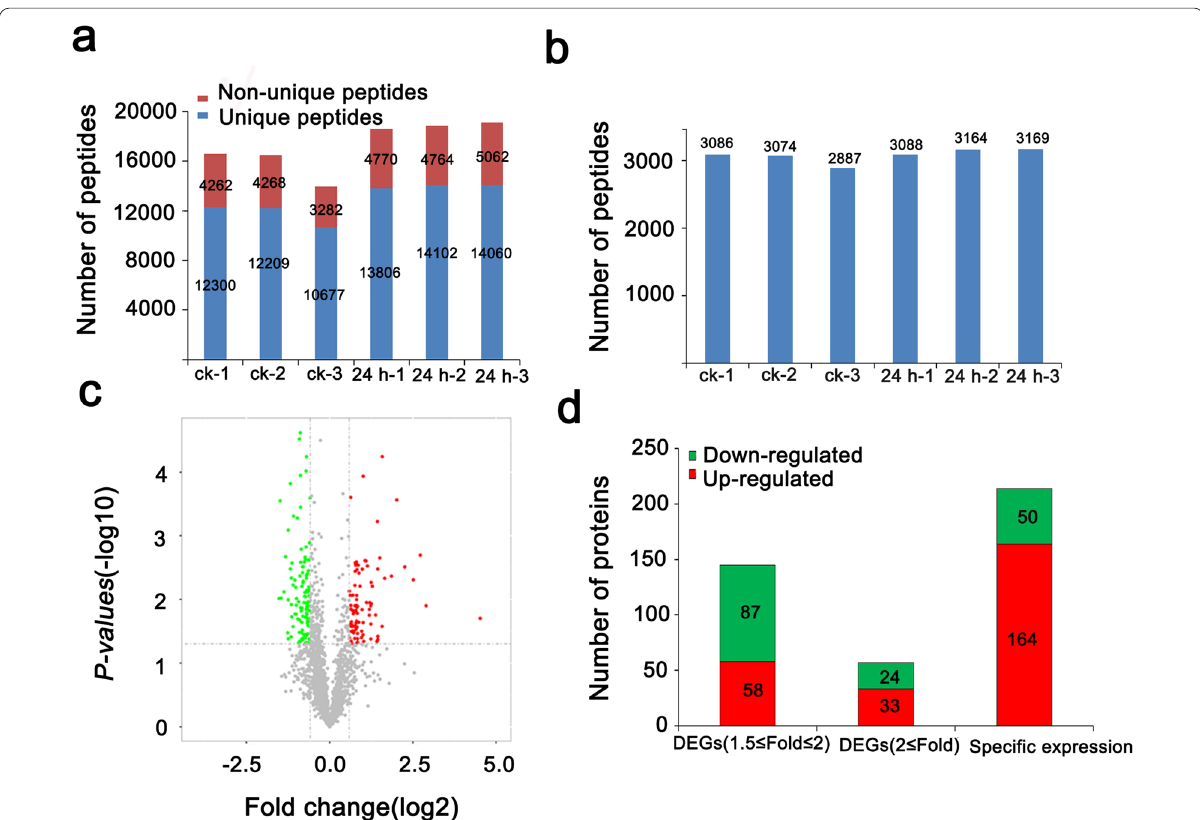
Fig. 4 Statistics of protein identification results. a The number of peptides identified by LC–MS/MS. b The number of proteins identified by LC–MS/ MS. c The volcano plot of the proteins identified in the CK and treatment. d The number of up- and down-regulated